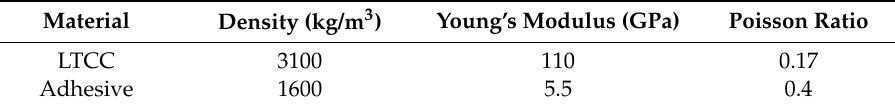
Table A1. Material properties of LTCC and adhesive.